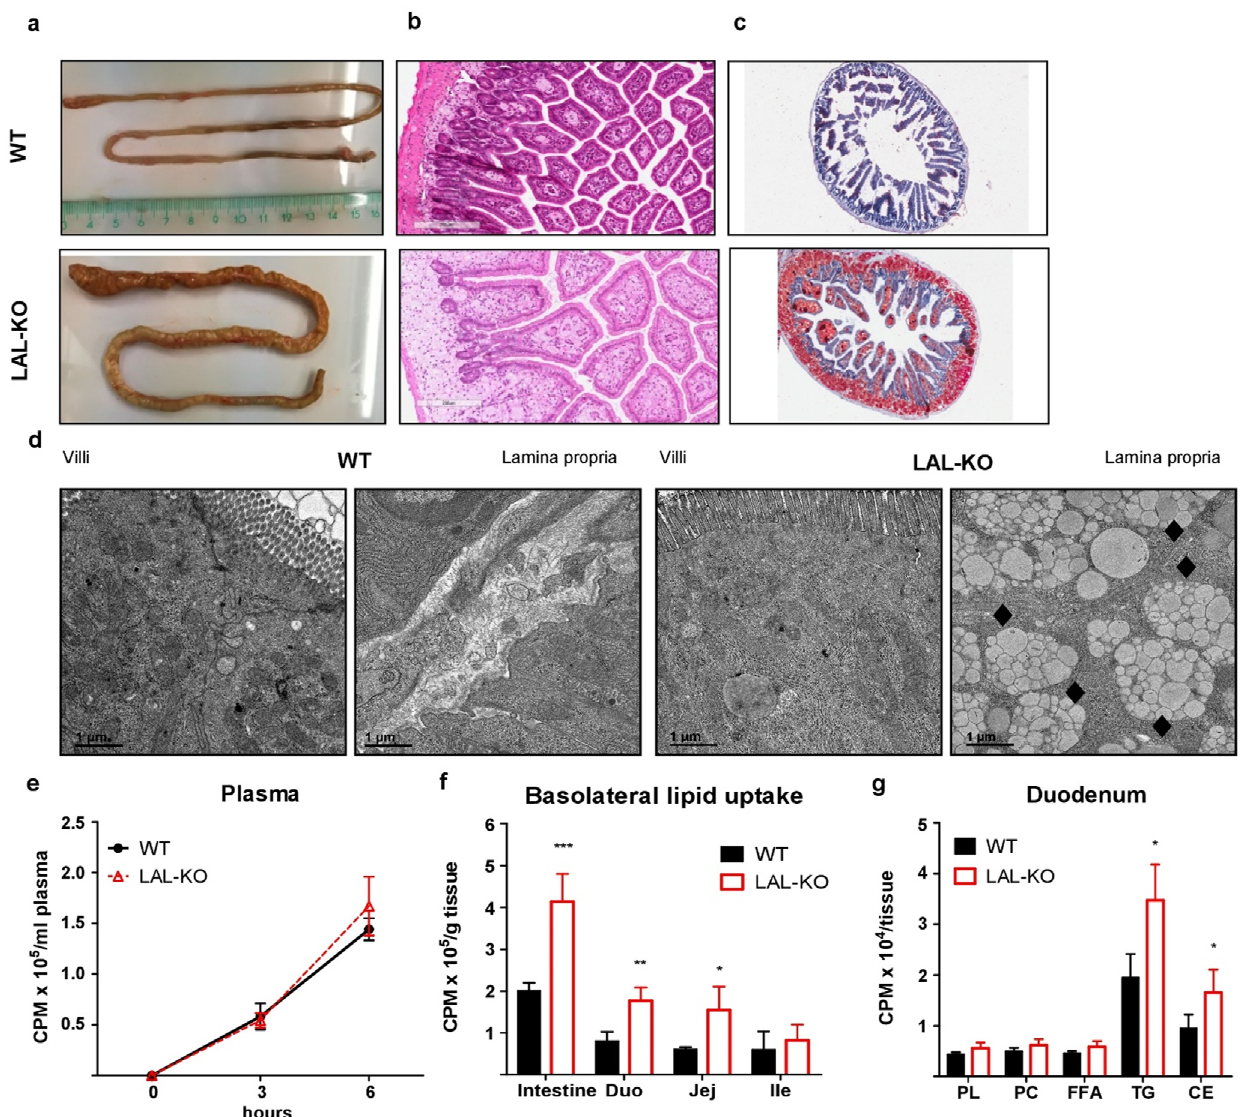
Figure 3. Intestines of LAL-KO mice accumulate lipids derived from the systemic circulation: ( a ) Representative photographs of the small intestine, micrographs of ( b ) H&E, and ( c ) oil red O-stained duodena from male WT and LAL-KO mice (17 weeks of age). ( d ) Representative duodenal electron micrographs; scale bar, 1 µm; black symbols indicate lipid-filled lysosomes in the lamina propria. Radioactivity in ( e ) plasma, ( f ) small intestine, and ( g ) absolute lipid distribution in duodenum 6 h post intraperitoneal injection of [ 3 H]oleate in intralipid (n = 4, 20-week-old female mice). Data represent mean values ± SD; p < 0.05 (*), p ≤ 0.01 (**), p ≤ 0.001 (***); ( e – g ) Student’s unpaired t-test.